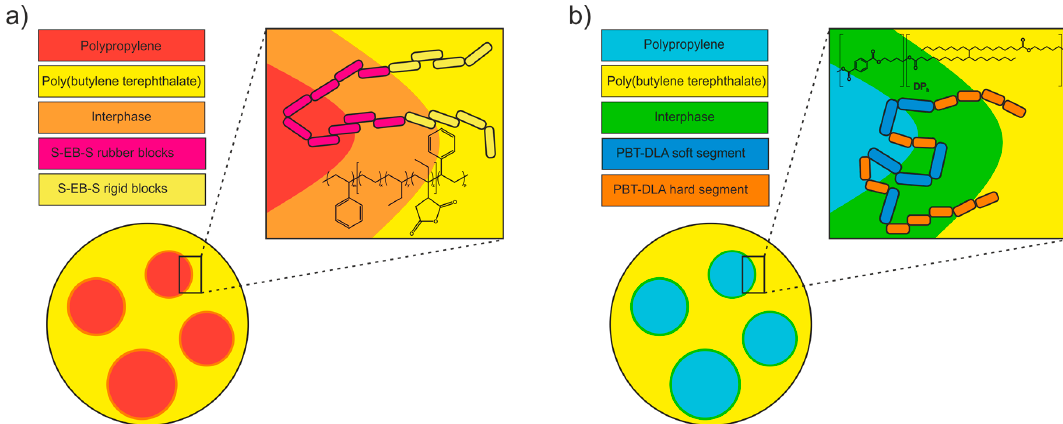
Figure 17. Probable compatibilization mechanisms using two different compatibilizers: ( a ) commercial triblock SEBS- g -MA copolymer; ( b ) polycondensation random PBT–DLA copolymer.